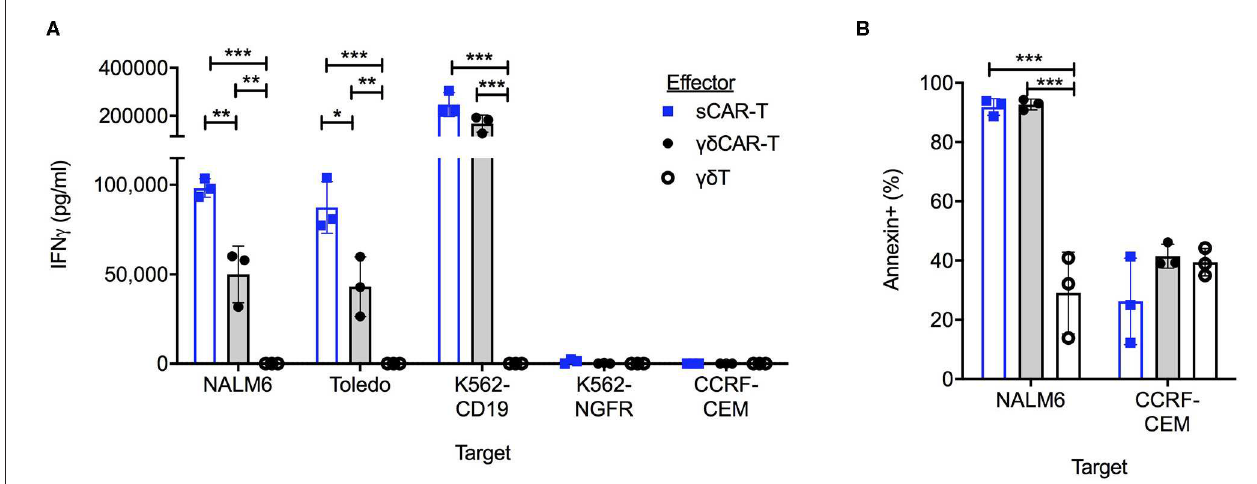
FIGURE 2 | γδ CAR-T cells demonstrate CD19 target dependent activity. (A) IFN γ levels in co-culture medium of listed effectors with CD19 positive and negative target cells. (B) Cytotoxic activity of effector cells against CD19 positive Nalm6 cells and CD19 negative CCRF-CEM cells. Cell trace violette pre-stained targets were evaluated for Annexin binding by FACS analysis. Blue bars, sCAR; Gray bars, γδ CAR-T; White bars, γδ -T cells. * P ≤ 0.05, ** P ≤ 0.01, *** P ≤ 0.001, Two tailed paired T -test. Error bars represent standard deviation.